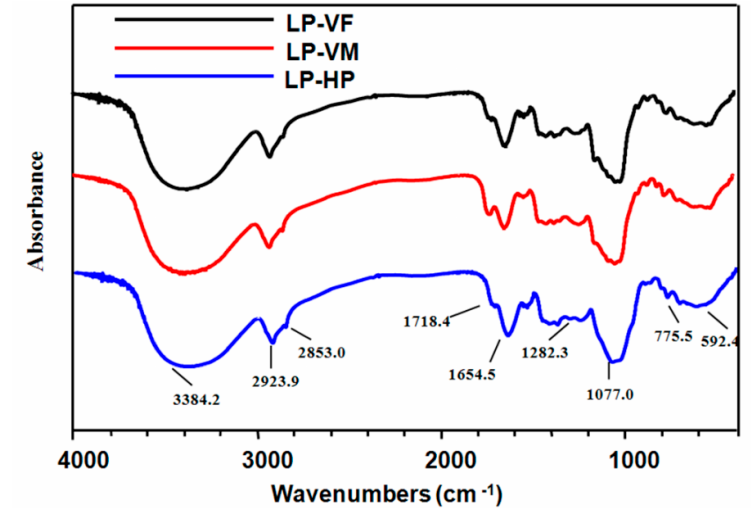
Figure 2. FT-IR spectra of polysaccharide-protein complexes. The FT-IR spectra of litchi polysaccharide-protein complexes were determined using a Fourier-transform infrared spectrophotometer over the frequency range of 4000–400 cm − 1 . LP-VF: